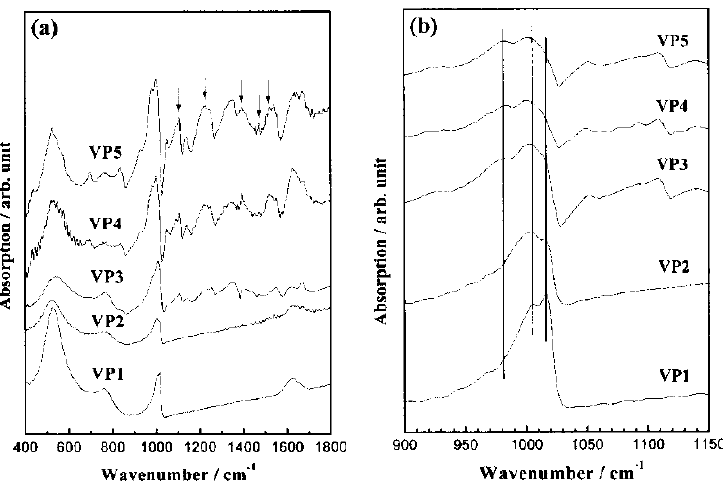
FIGURE 5 Infrared spectra for VP1, VP2, VP3, VP4 and VP5 in the range of (a) 400–1800cm (cid:3) 1 and (b) 900– 1150cm (cid:3) 1 (enlargement). The samples were diluted with KBr and pressed into a pellet. Some important peaks from the polymer are marked with